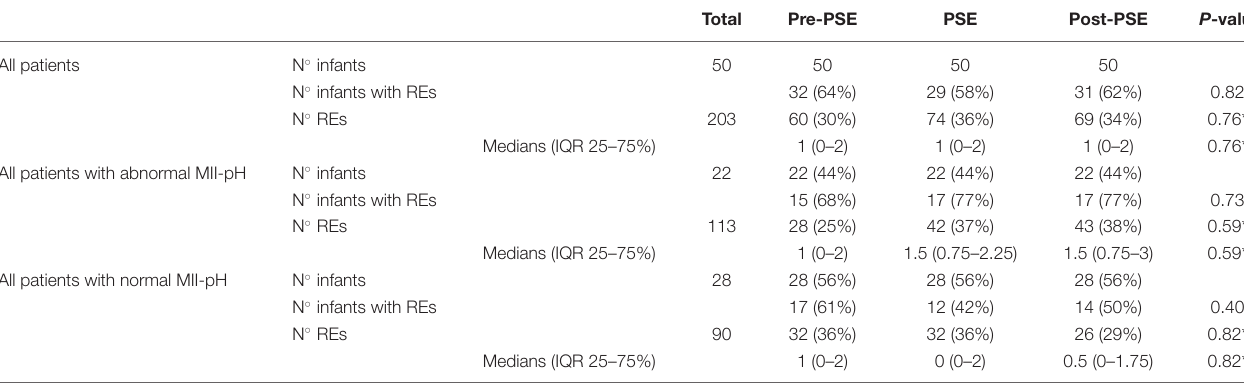
TABLE 2 | Results of the MII-pH monitoring: differences between pre-PSE, PSE, and post-PSE.